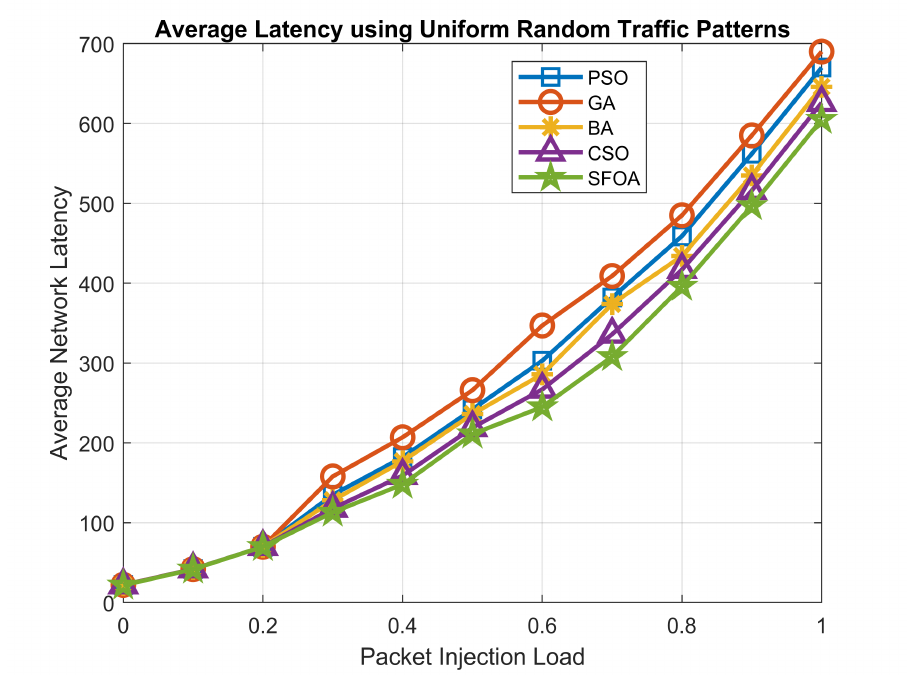
Figure 7. Average network latency for uniform random traffic patterns.